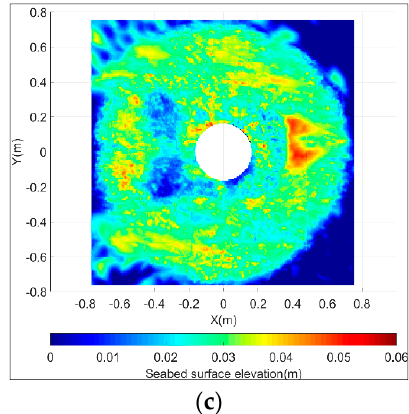
Figure 18. Topography of the scour protection material and of the sand pit measured by the laser scanner before Test 03 ( a ), after the first 1000 waves of Test 04_A ( b ) and after 3000 waves at the end of Test 04_B ( c ). The current propagation in this set of figures is from right to left.